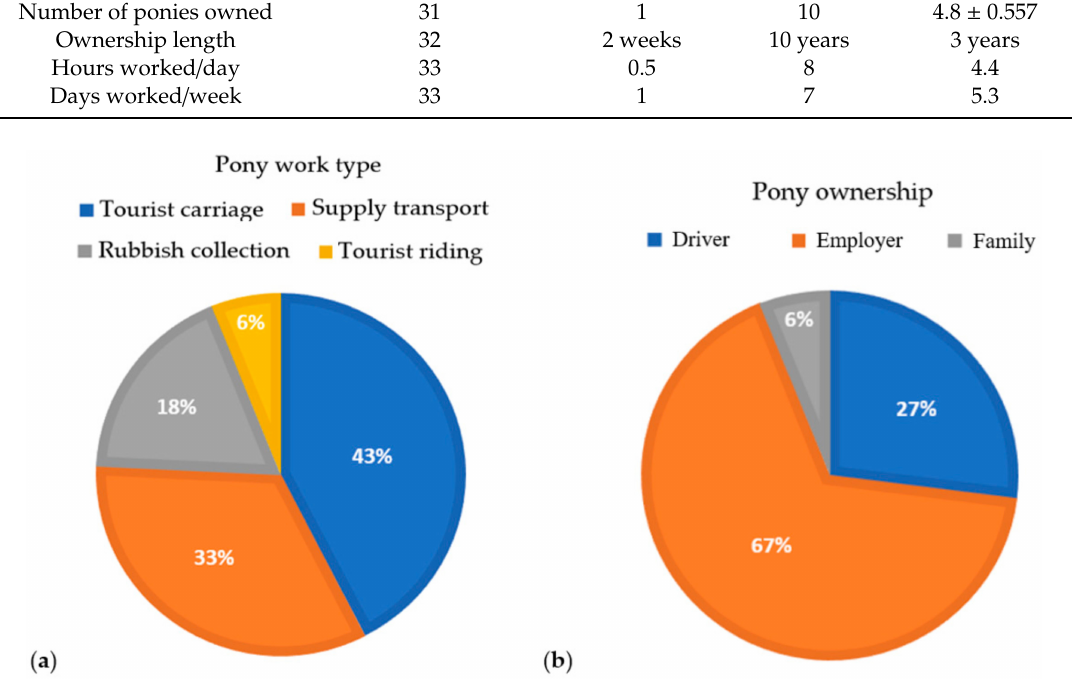
Figure 3. Distribution of ( a ) pony work type, and ( b ) pony